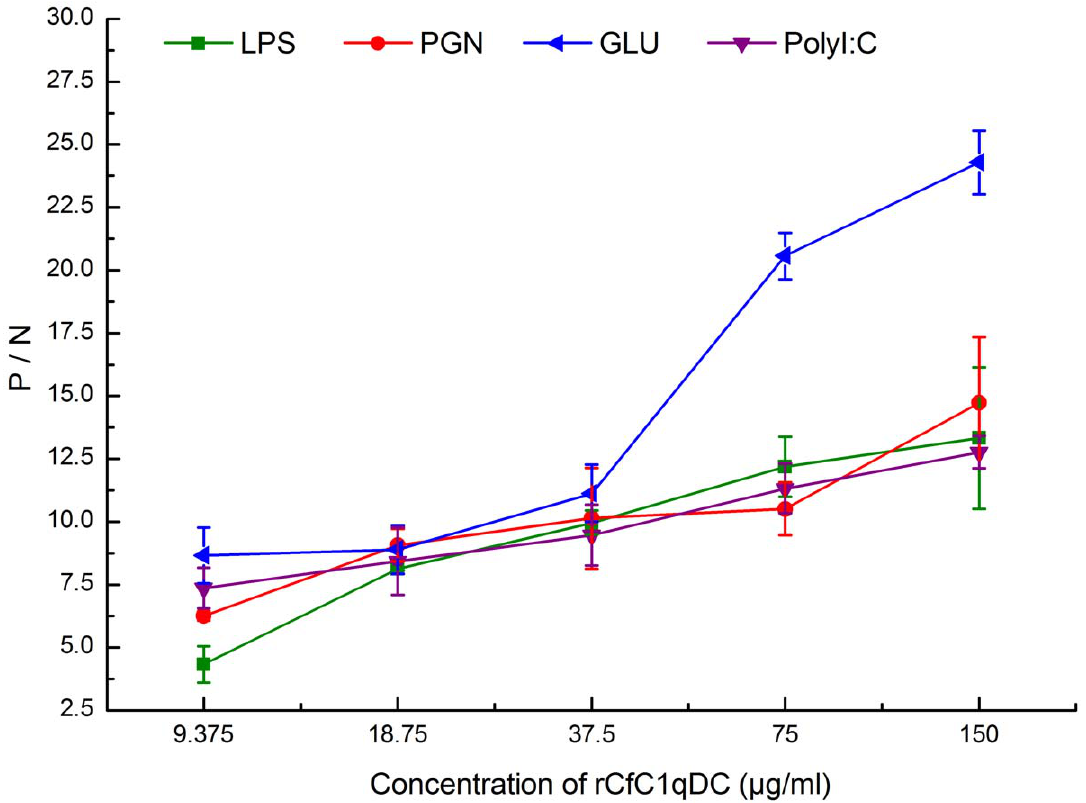
Figure 5. ELISA analysis of the interaction between rCfC1qDC and the PAMPs. Plates were coated with various PAMPs, and then incubated with several concentrations of rCfC1qDC and rTrx at 18 u C for 3 h. After incubated with rat polyclonal antiserum, the interaction was detected with goat–anti-rat Ig-alkaline phosphatase conjugate at 405 nm. Samples with P/N . 2.1 were considered positive. Results are representative of average three such experiments.